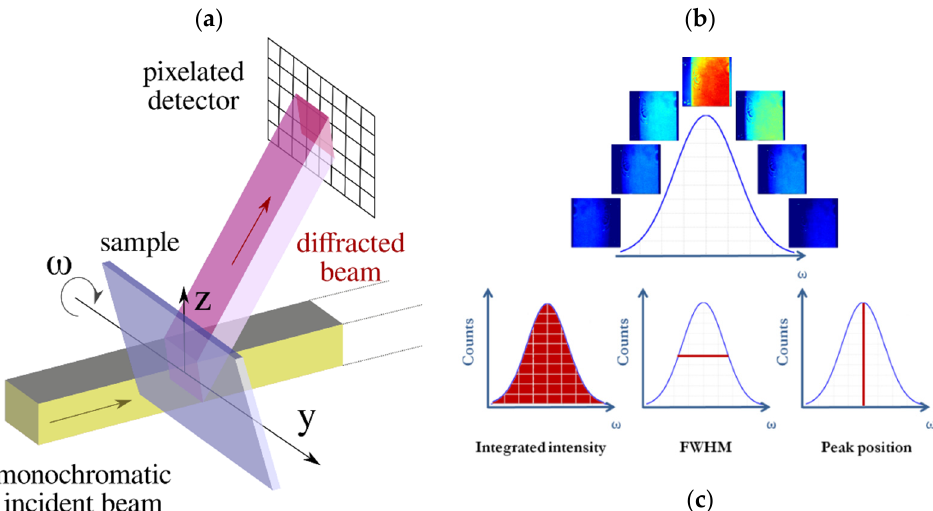
Figure 1. RCI technique: ( a ) the sample is in Bragg position for a chosen reflection; the diffracted intensity is recorded by a pixelated detector. ( b ) A series of images (~200) is recorded for different angular positions (rotation ω ) along the rocking curve corresponding to the whole sample; a few representative images along the rocking curve of the 4H ‐ SiC crystal are displayed. ( c ) RCI maps generated from the rocking curves recorded on each of the pixels of the detector show the variation across the crystal of the integrated intensity, peak width and peak position (in ω ).